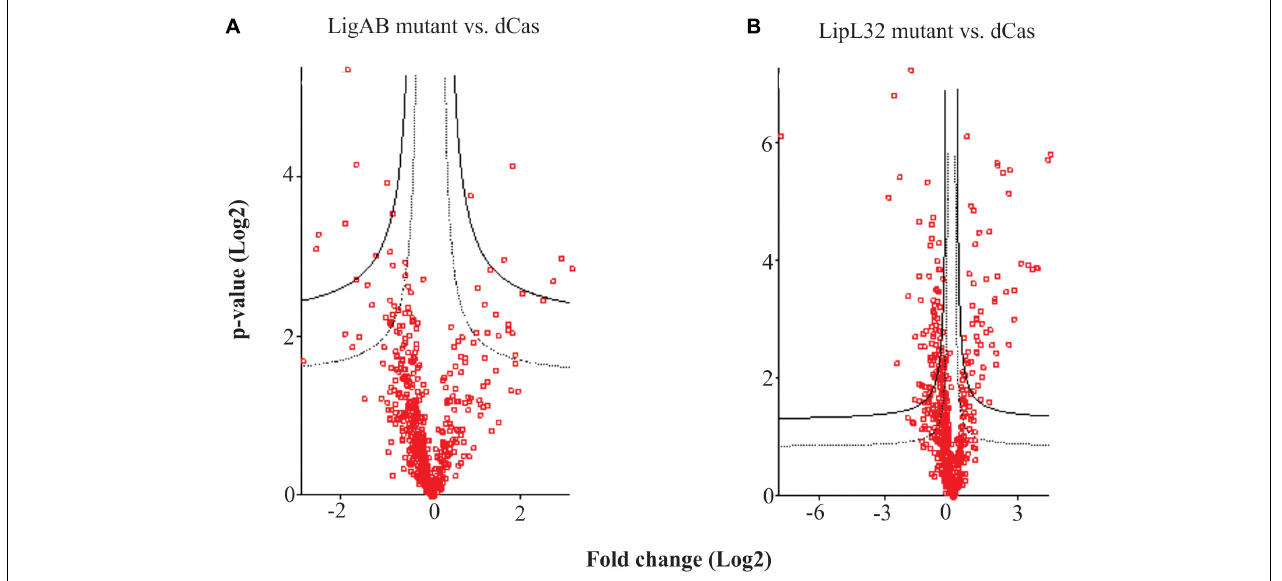
FIGURE 2 | Hawaii plots showing differential expression of proteins between mutant and empty dCas9 plasmid leptospires. Depicted are the differences between LigAB mutant preparations (A) , and LipL32 mutants (B) compared with dCas9 alone control samples. The solid line represents an FDR of 0.01 and dotted line represents an FDR of